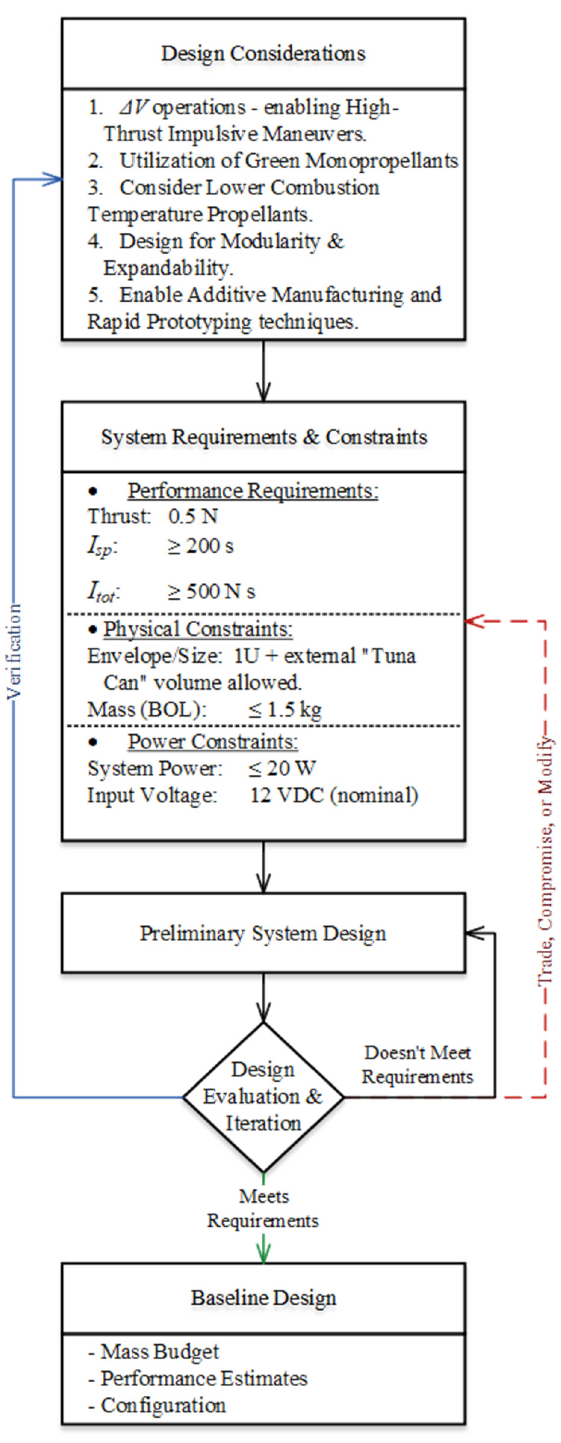
Figure 4. UML schematic diagram of MIMPS-G design process.